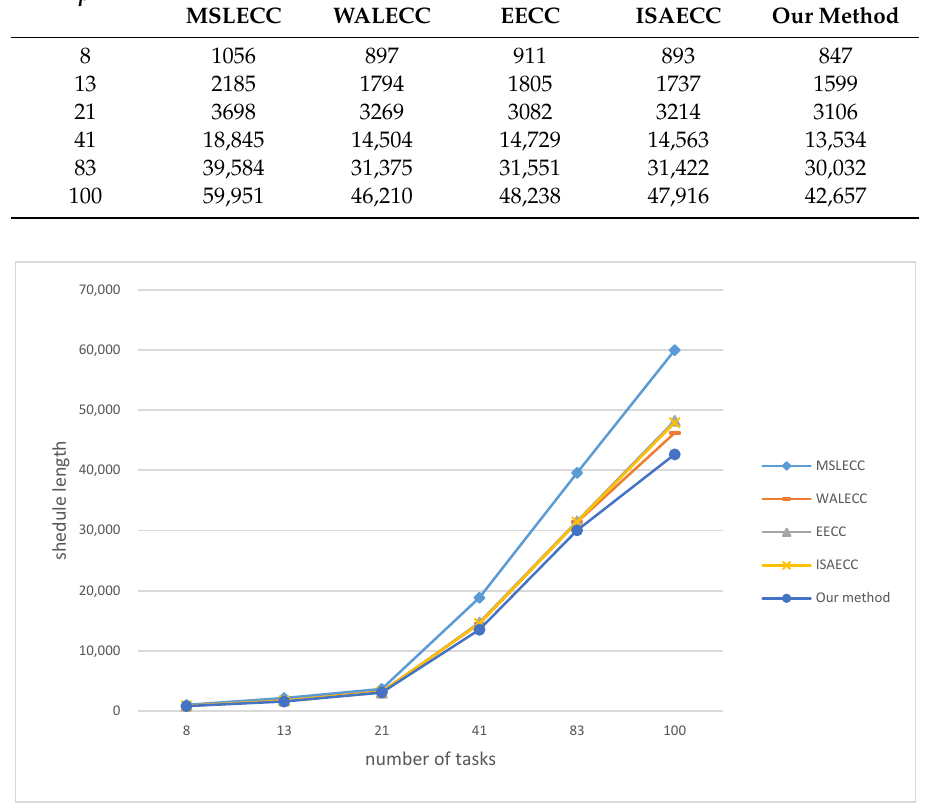
Figure 7. Final schedule length of GE application varying number of tasks.